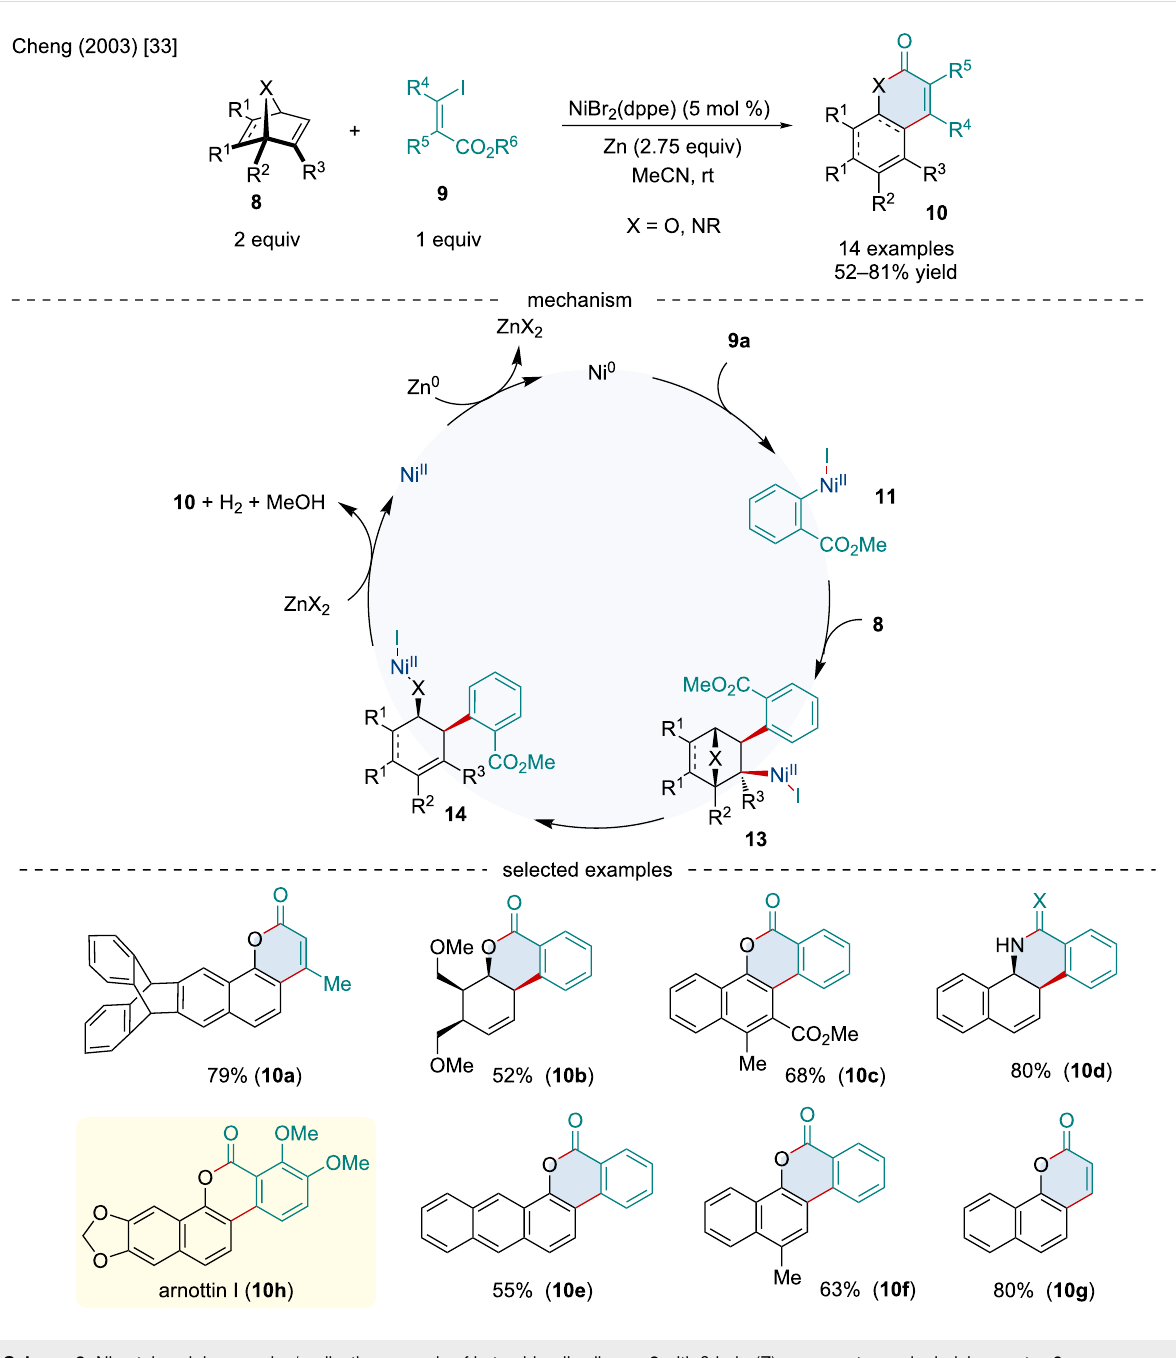
resulted in the corresponding 1,5-enyne only being produced in a 33% yield. Several different norbornene derivatives were explored and gave the anticipated exo,exo- difunctionalized product in good yield. In contrast, when using an ethylene- bridged bicycloalkene to generate the product 19c , the latter was obtained in a greatly reduced yield, perhaps due to less ring strain providing a thermodynamic driving